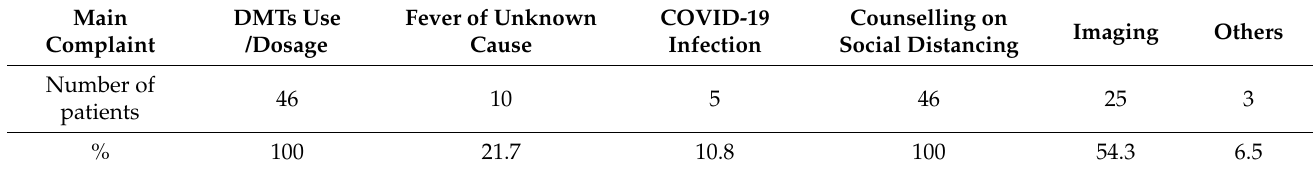
Table 2. Main reason/complaints of patients seen in